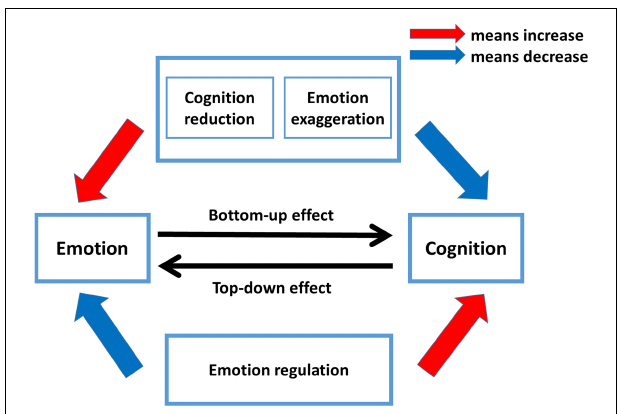
FIGURE 3 | The interactive influence model of emotion and cognition (IIEC). Decision making depends upon the interaction of emotion and cognition. Two typical contexts, namely cognition reduction (cognitive capacity is reduced) and emotion exaggeration (emotional reaction is enhanced), increase the power of emotion but decrease the power of cognition. The cognition reduction can be seen in decision setting such as ambiguity, time constraint, and ego depletion. The emotion exaggeration can be observed in decision settings such as proximity, social distance, and social instinct. In these two contexts, emotion can overwhelm cognition and exert a bottom-up influence on decision making. Cognition can modulate emotion reaction by consciously using emotion regulation strategies such as attention deployment, cognitive change, and response modulation. These emotion regulation strategies help to strengthen the capacity of cognition and constraint the power of emotion. With emotion regulation, cognition can exert a top-down effect during decision